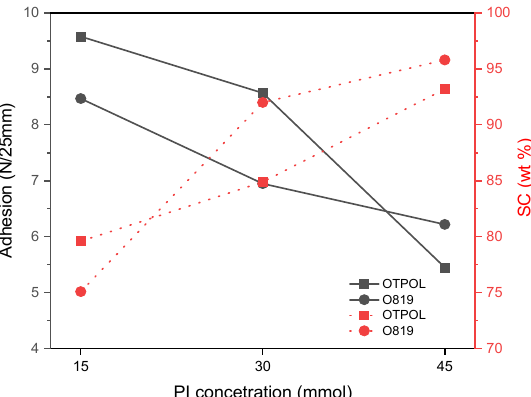
Figure 6. Dependence of adhesion to steel and solid content on photoinitiator concentration.